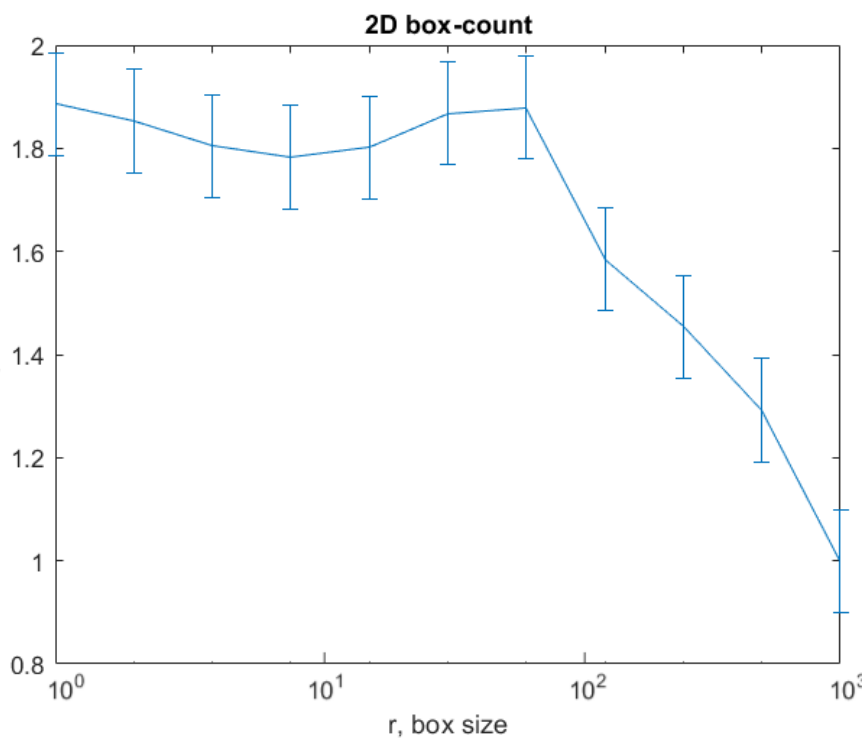
Figure 15. Primary processing of the selected image U 4 . ( a ) — original image (the entire portion); ( b ) — the grayscale version; ( c ) — the gray scale version without luminance; ( d ) — binarized version. A threshold of 35 was used for binarization.